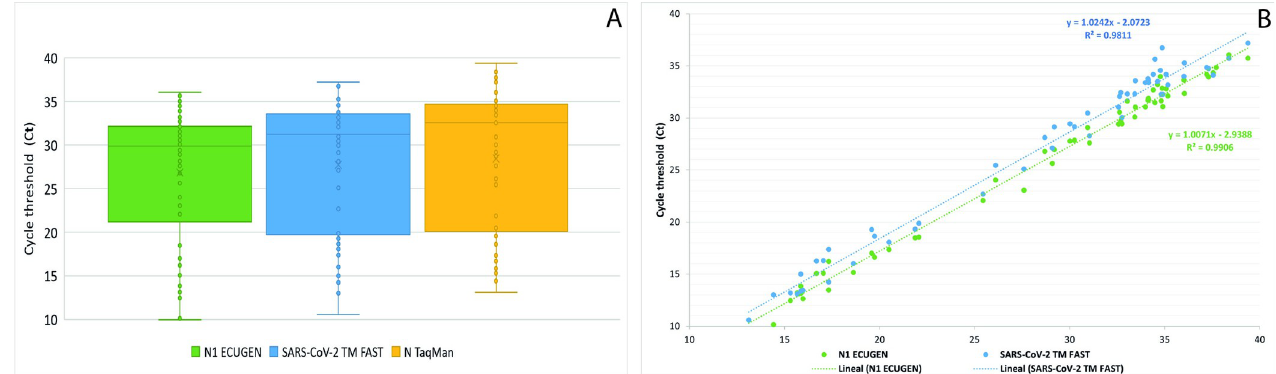
Fig 1. A: Cycle threshold (Ct) distribution for N gene target for SARS-CoV-2 positive samples with the three commercial kits included in this study: ECUGEN SARS-CoV-2 RT-qPCR Kit (green), COVID-19 RT-PCR Real TM FAST (blue) and TaqMan 2019-nCoV Assay Kit v1 (yellow). B: Linear regression for the Ct values for N gene target for ECUGEN SARS-CoV-2 RT-qPCR Kit (green) and COVID-19 RT-PCR Real TM FAST (blue) compared to TaqMan 2019-nCoV Assay Kit v1.